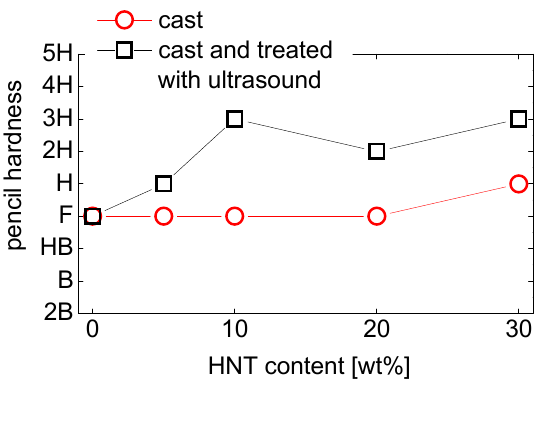
Figure 5. Pencil hardness versus degree of loading for non-silanized HNTs with (squares) and without (circles) sonication of the sample during